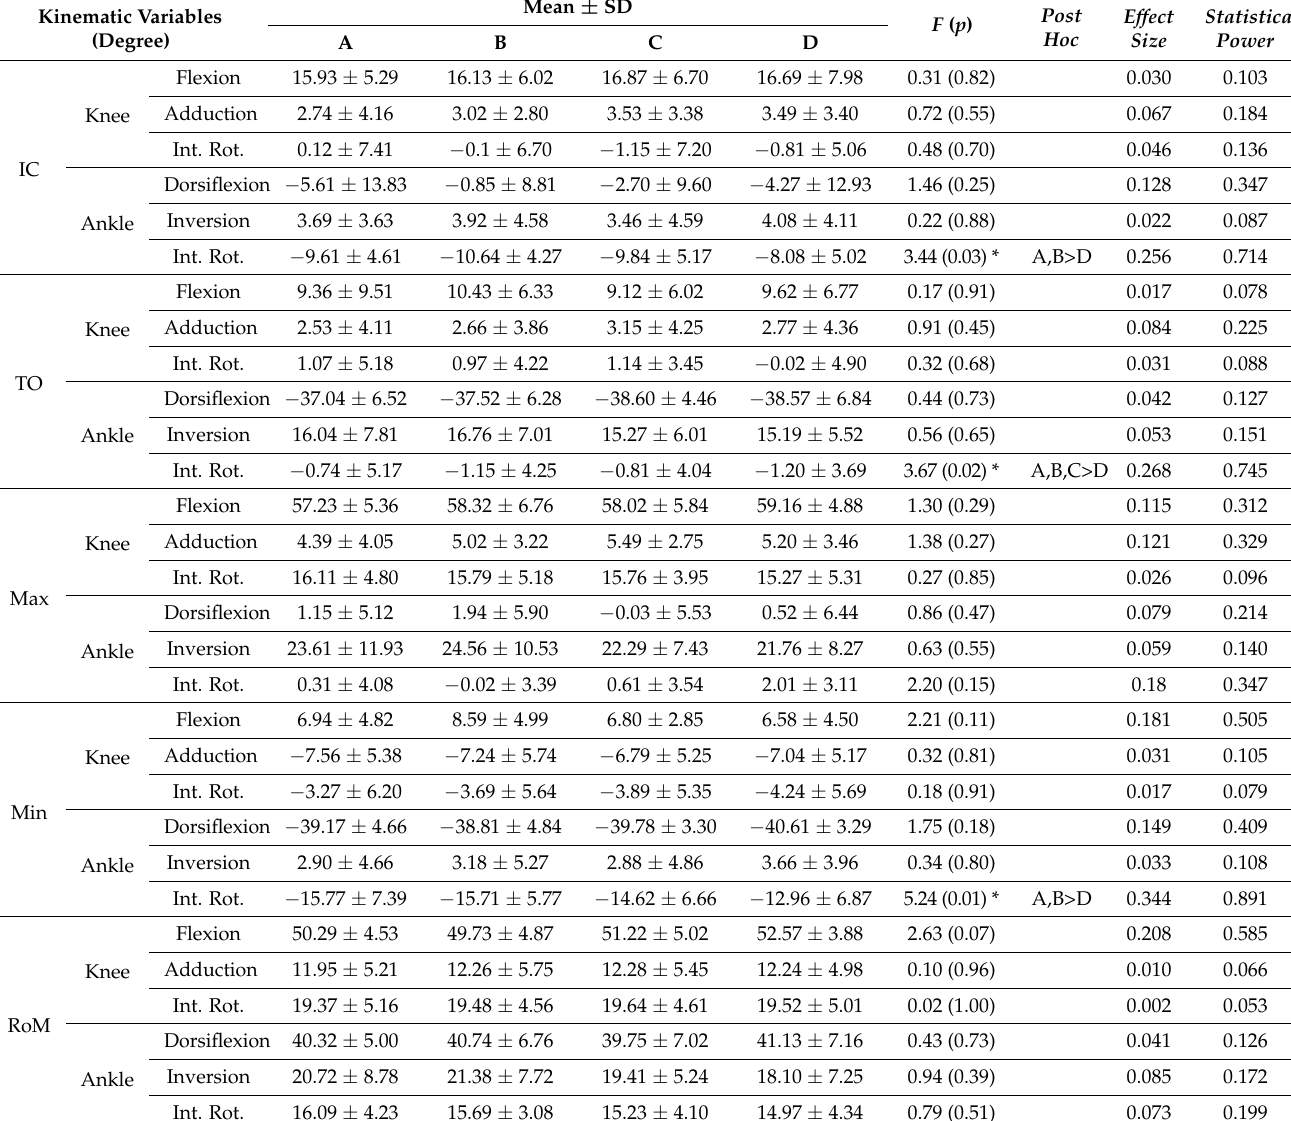
Table A1. Joint angles upon forward braking motion in a biomechanical